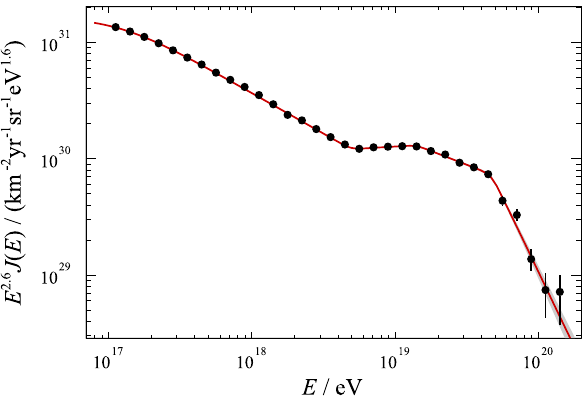
Fig. 17 SD energy spectrum after combining the individual measure- ments by the SD-750 and the SD-1500 scaled by E 2 . 6 . The fit using the proposed function (Eq. (13)) is overlaid in red along with the one sigma error band in